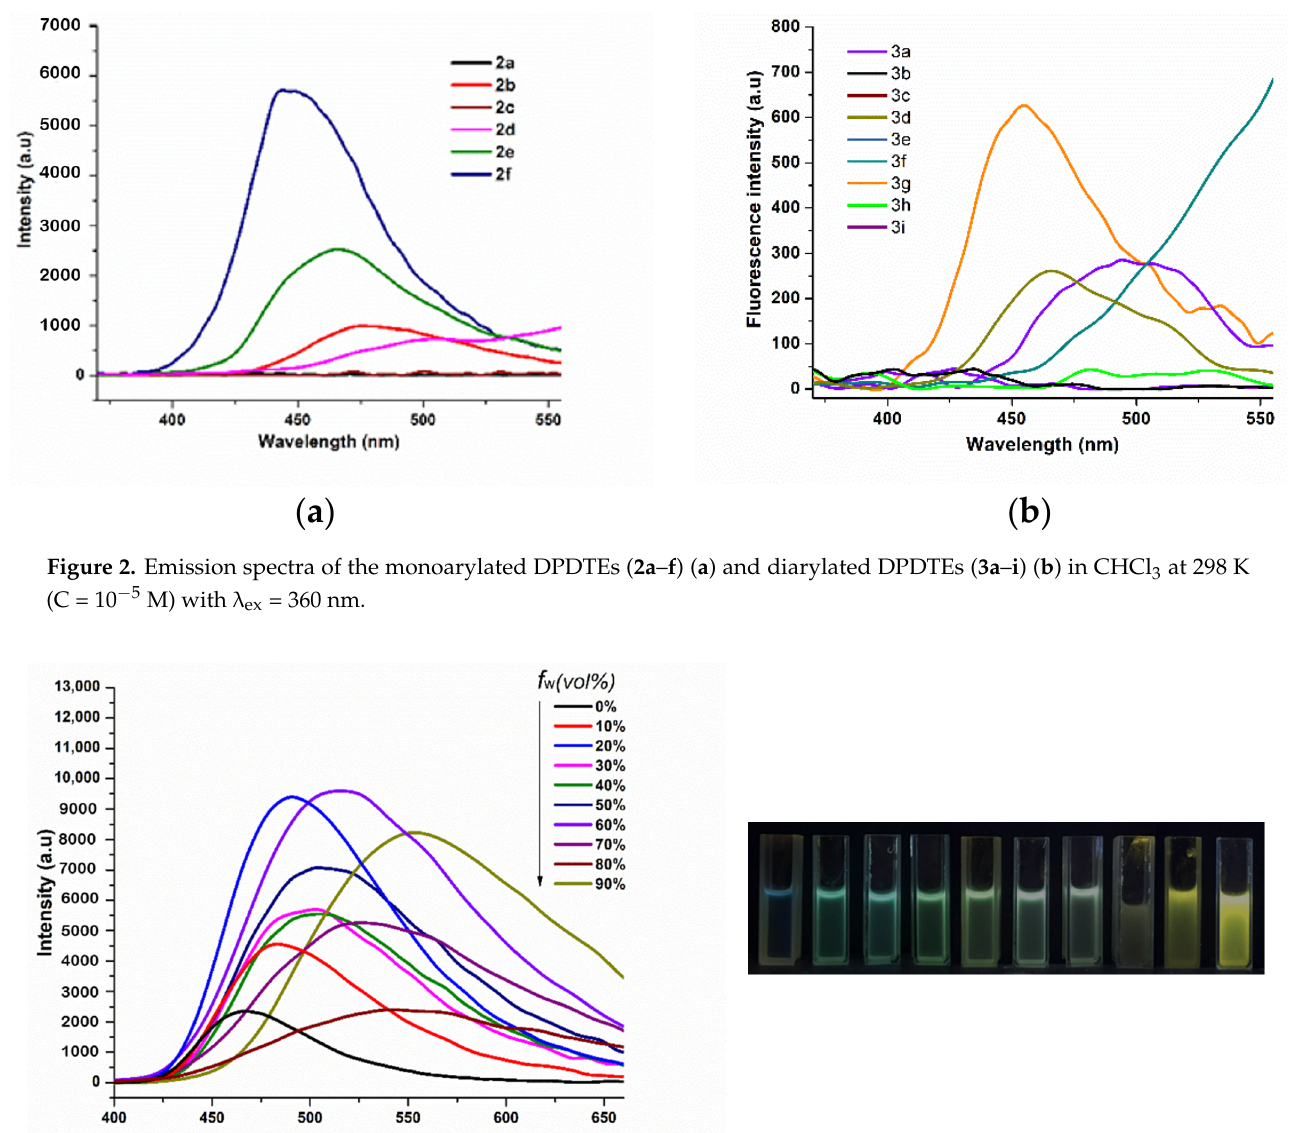
Figure 1. Absorption spectra of the monoarylated DPDTEs ( 2a – f ) ( a ) and diarylated DPDTEs ( 3a – i ) ( b ) at 298 K in CHCl 3 solution (C = 10 − 5 M).